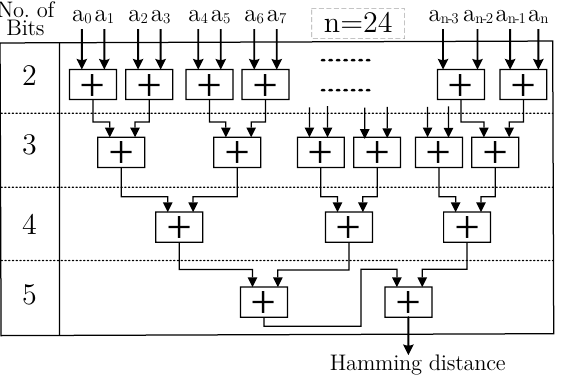
Figure 14. Optimized hardware implementation with arbitrary width adders.